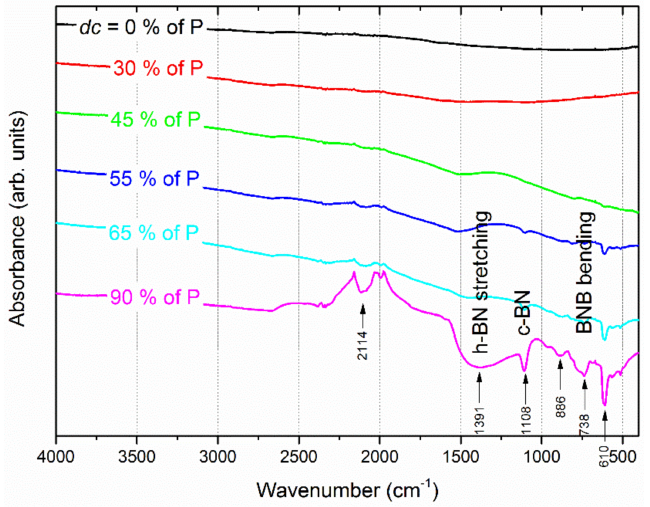
Figure 5. FTIR spectra measured for Ti-B-N films prepared by pulsing nitrogen gas with an increasing duty cycle from 0 to 90% of the pulsing period of P = 10